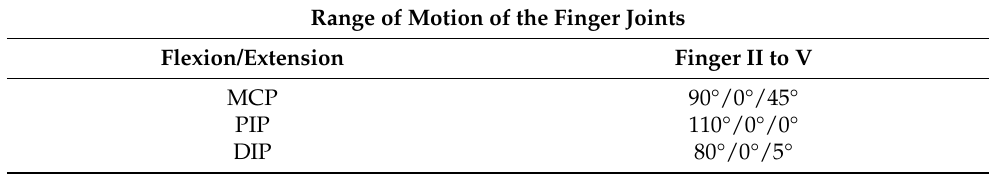
Table A2. Range of motion of the Distal Interphalangeal (DIP), Metacarpophalangeal (MCP), Proximal Interphalangeal (PIP) joints according to